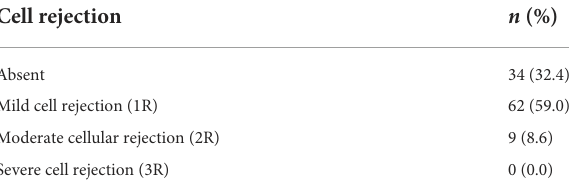
TABLE 8 Prevalence of antibody-mediated (humoral) rejection to heart